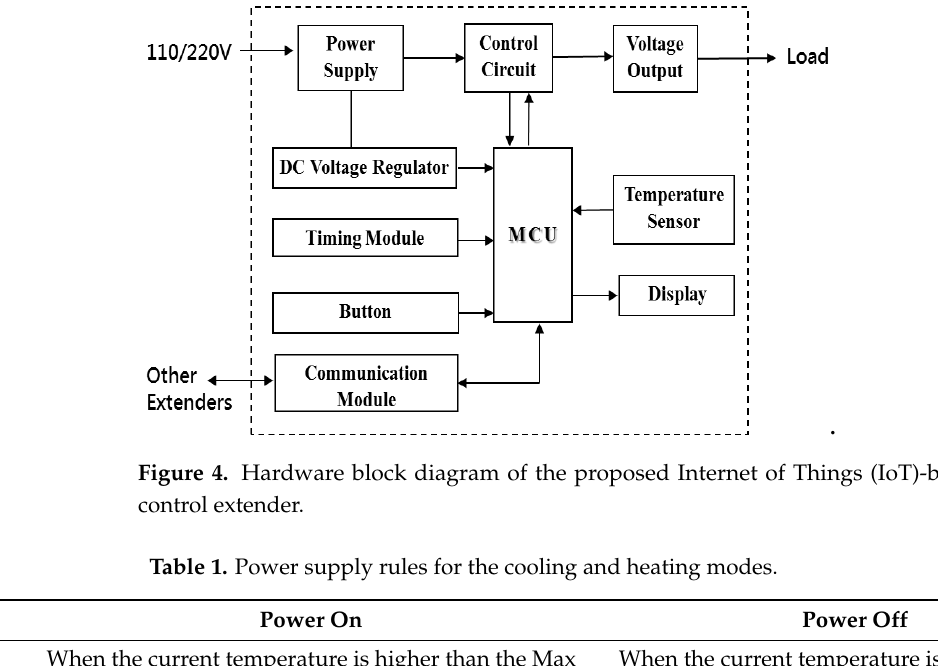
Figure 3. System architecture.